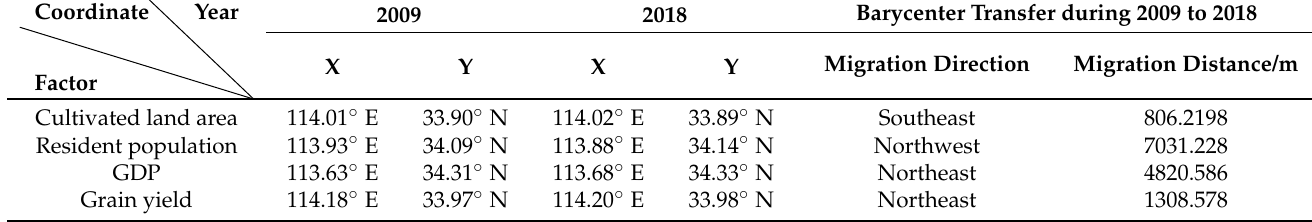
Figure 6. The barycenter transfer map. Table 2. Barycenter transfer of two-period factors data from 2009 to 2018.